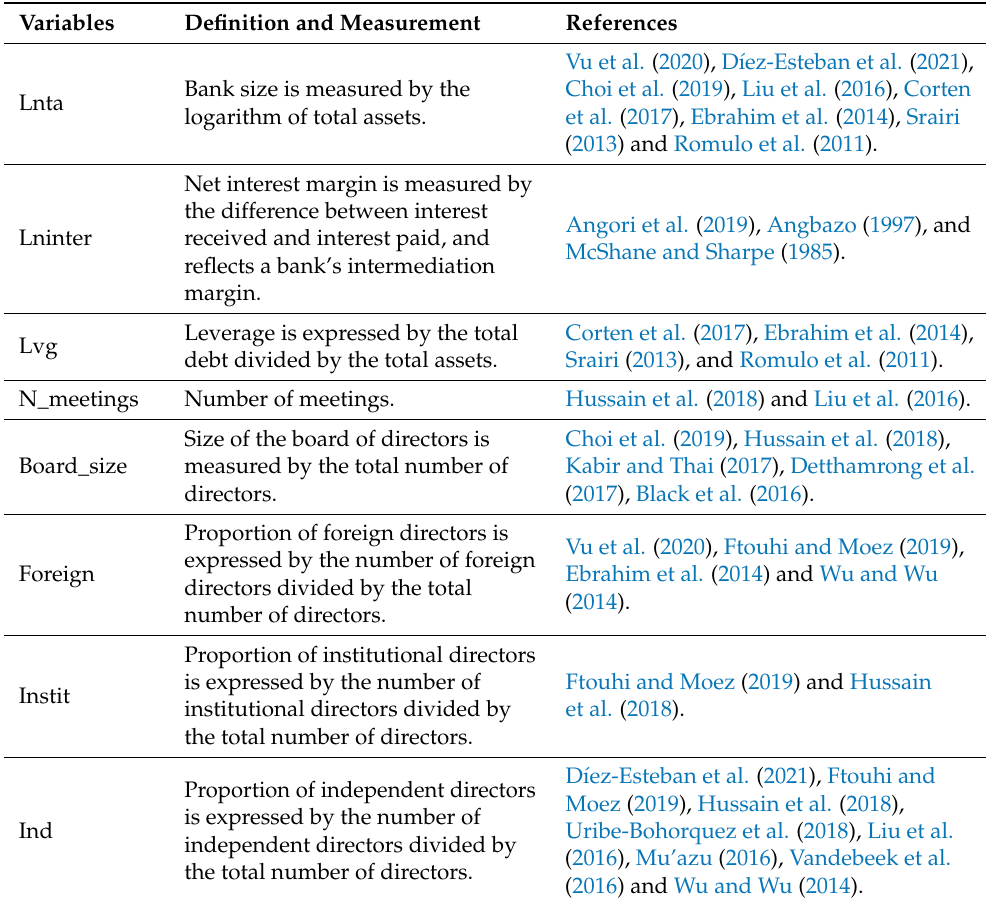
Table 2. Definition of independent